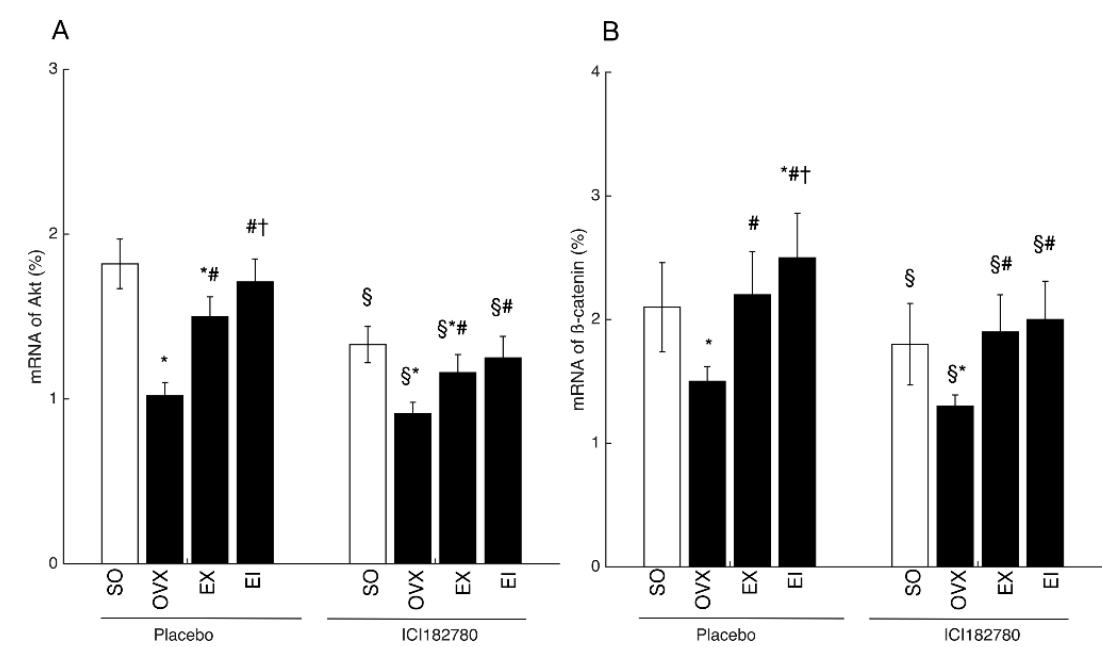
Figure 4. The e ff ects of ICI182780 treatment on the mRNA expression of Akt and β -catenin. SO: Sham-operated; OVX: ovariectomized; EX: exercise; EI: exercise and Icariin. 1. Comparison of the groups of OVX, EX, and EI with SO group: * < 0.05. 2. Comparison of EX and EI groups with OVX group: # < 0.05. 3. Comparison between EX with EI group: † < 0.05. 4. Comparison between placebo and ICI182780 treatment: § <